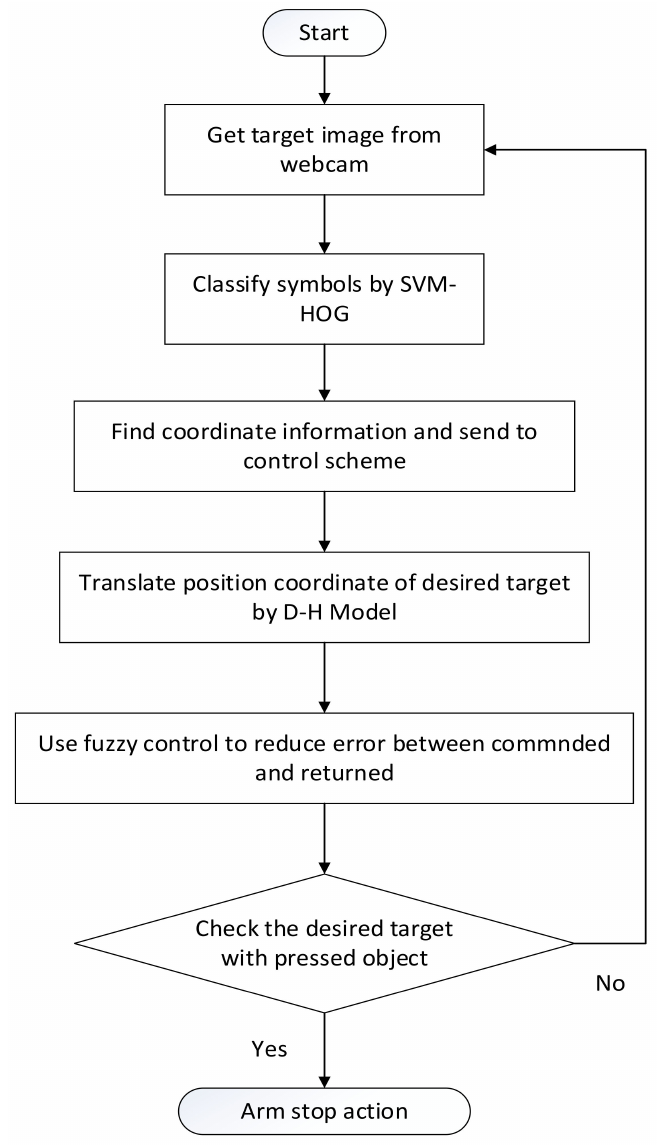
Figure 24. Flowchart of the control